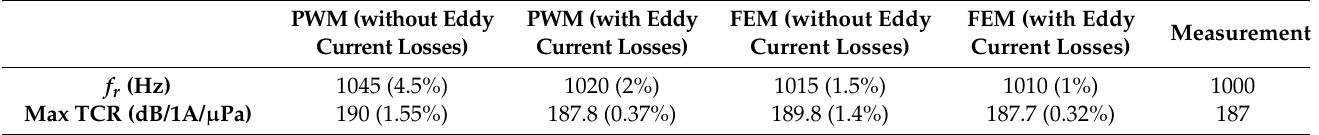
Figure 16. Comparison of the TCR for PWM, FEM, and measurement. Table 4. The parameters calculated by modeling methods and their relative deviations (%) from the measurement results.